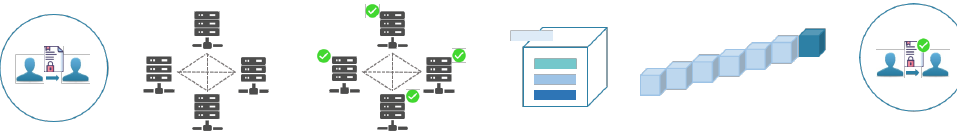
Figure 1. Blockchain transaction processing: (1) Transaction request, (2) Transaction broadcast to P2P network nodes, (3) Transaction verification using consensus algorithms, (4) Transaction packed into block with other transactions, (5) The block added to the blockchain, (6) Transaction completed Essentially, there are four types of blockchain: public, private, consortium and